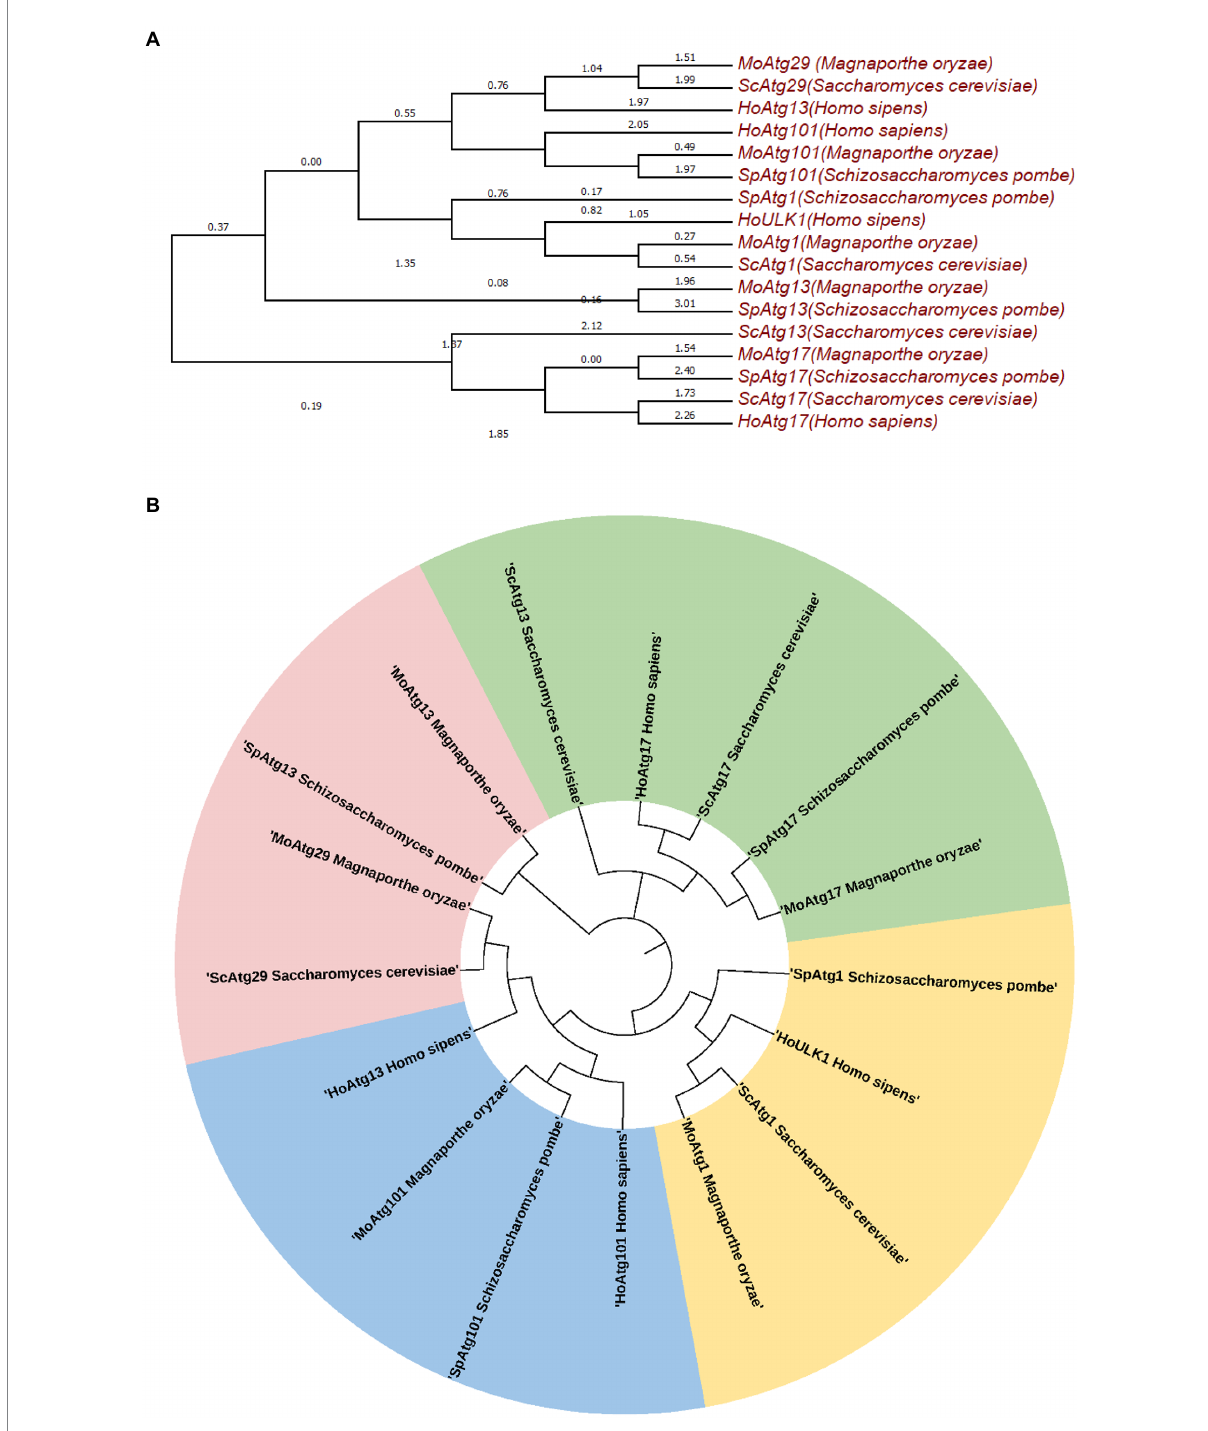
FIGURE 2 Molecular phylogenetic analysis by the maximum likelihood method (A,B) . The evolutionary history was inferred using the maximum likelihood method based on the JTT matrix-based model. The tree with the highest log likelihood ( − 7283.2388) is shown. Initial tree(s) for the heuristic search are obtained automatically by applying the neighbor-joining and BioNJ algorithms to a matrix of pairwise distances estimated using a JTT model then selecting the topology with a superior log likelihood value. The analysis involved 17 amino acid sequences. All positions containing gaps and missing data were eliminated. There is a total of 160 positions in the final dataset. Evolutionary analyses were performed in MEGA7.